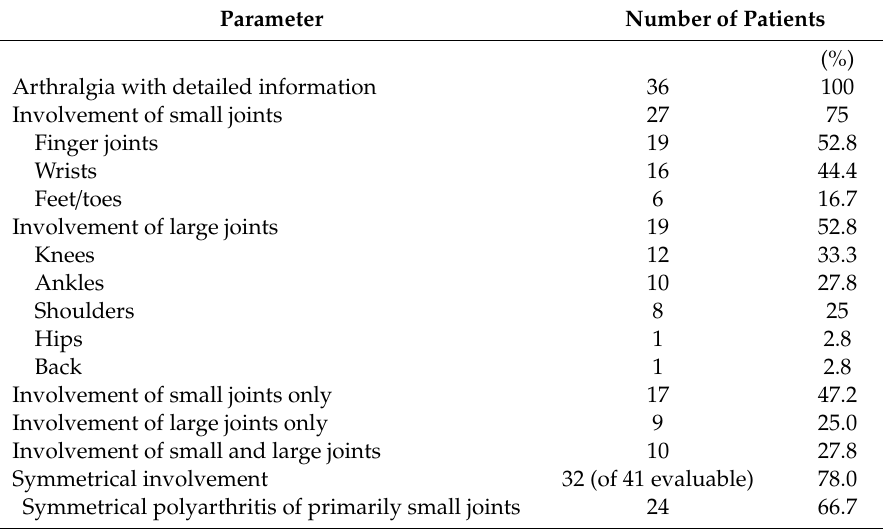
Table 3. Clinical presentation of